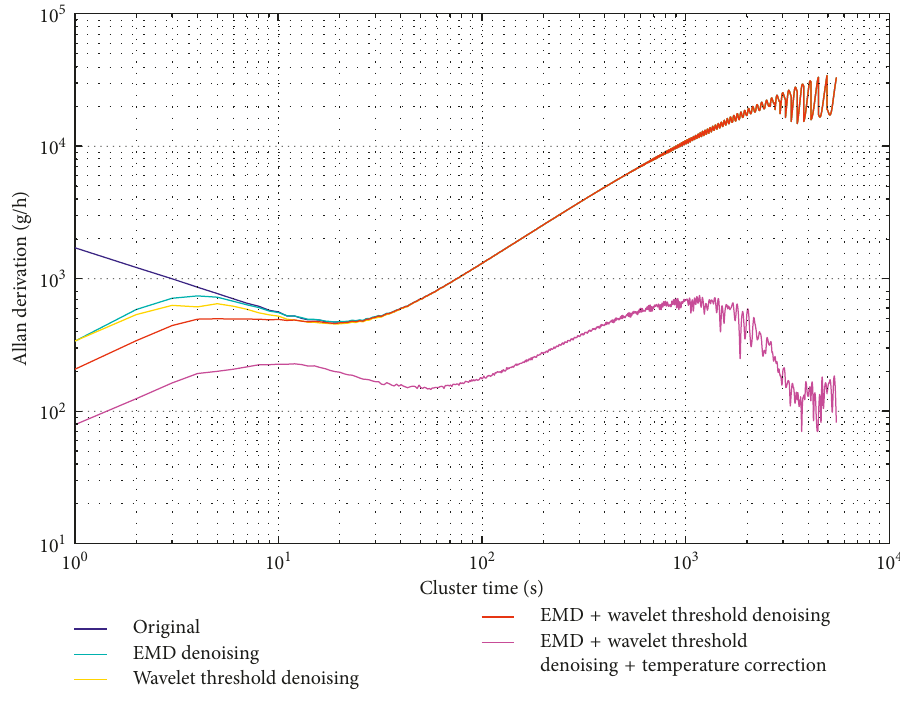
Figure 14: Allan variance plots of the four methods. Table 2: Results of Allah’s analysis of